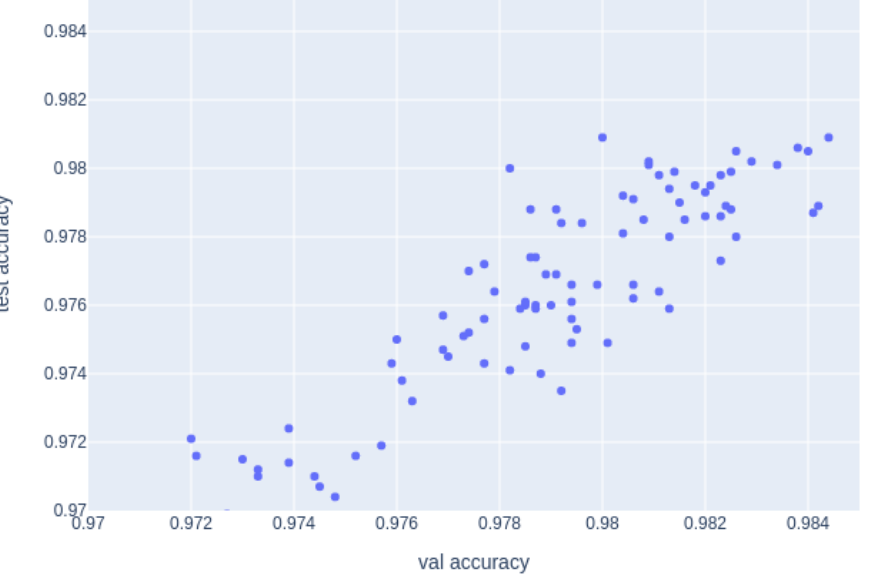
Figure 2. Comparison of the validation accuracy and test accuracy of the trained models. The models were trained based on 18 types of hyperparameters and 5 types of training and test data.